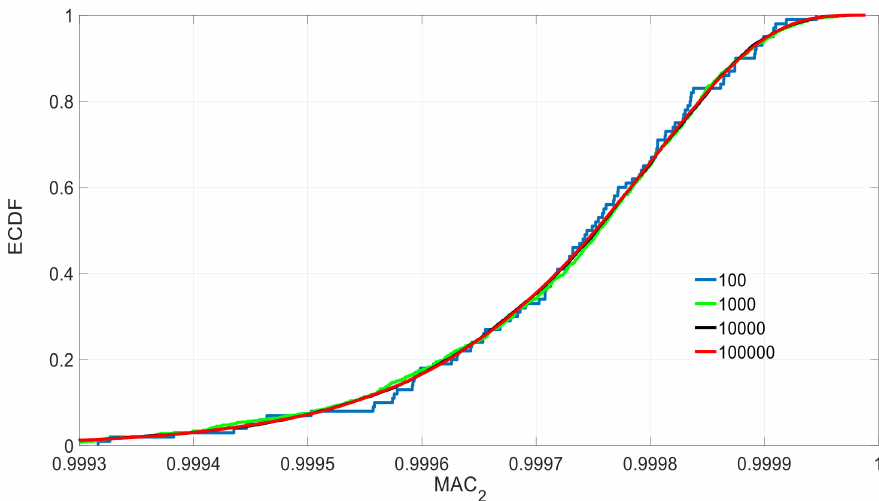
Figure 7. ECDF of MAC 2 under set C and different sample sizes.